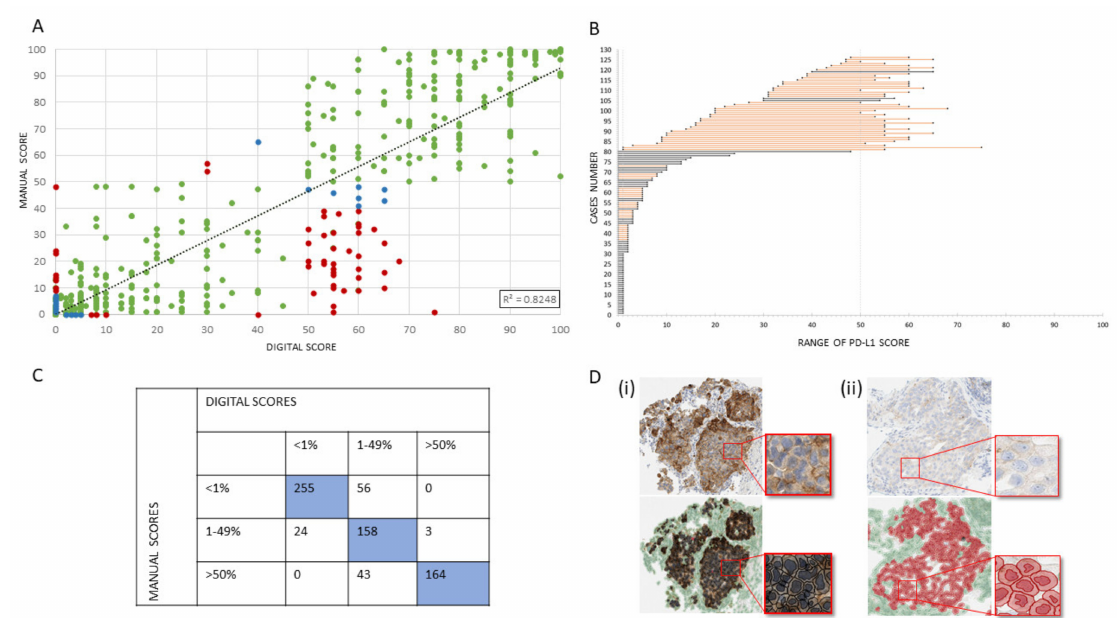
Figure 2. Concordance of manual PD-L1 assessment with digital pathology. ( A ) Correlation of scores by the two methodologies. Categorical agreement is represented by green data points; acceptable discordance by blue data points; and unacceptably discordance cases by red data points. ( B ) The range of discordance across the clinical thresholds for each of the 126 discordant cases. Data points specify a PD-L1 score. Black connecting lines connect a lower digital scores to a higher manual score, while an orange line connects a lower manual score to a higher digital score. ( C ) Categorical concordance and discordance in terms of total numbers. ( D ) (i) Concordant comparison between manual and digital assessment in a case which was high for PD-L1 expression. Figure 2D (ii) A non-concordant comparison from a low PD-L1 expressing case. In these examples, the image analysis mask describes PD-L1 + tumor cells in black and PD-L1- tumor cells in red, with stromal cells shown in green. Images are × 4 magnification with an exploded view of a higher magnification area at × 40